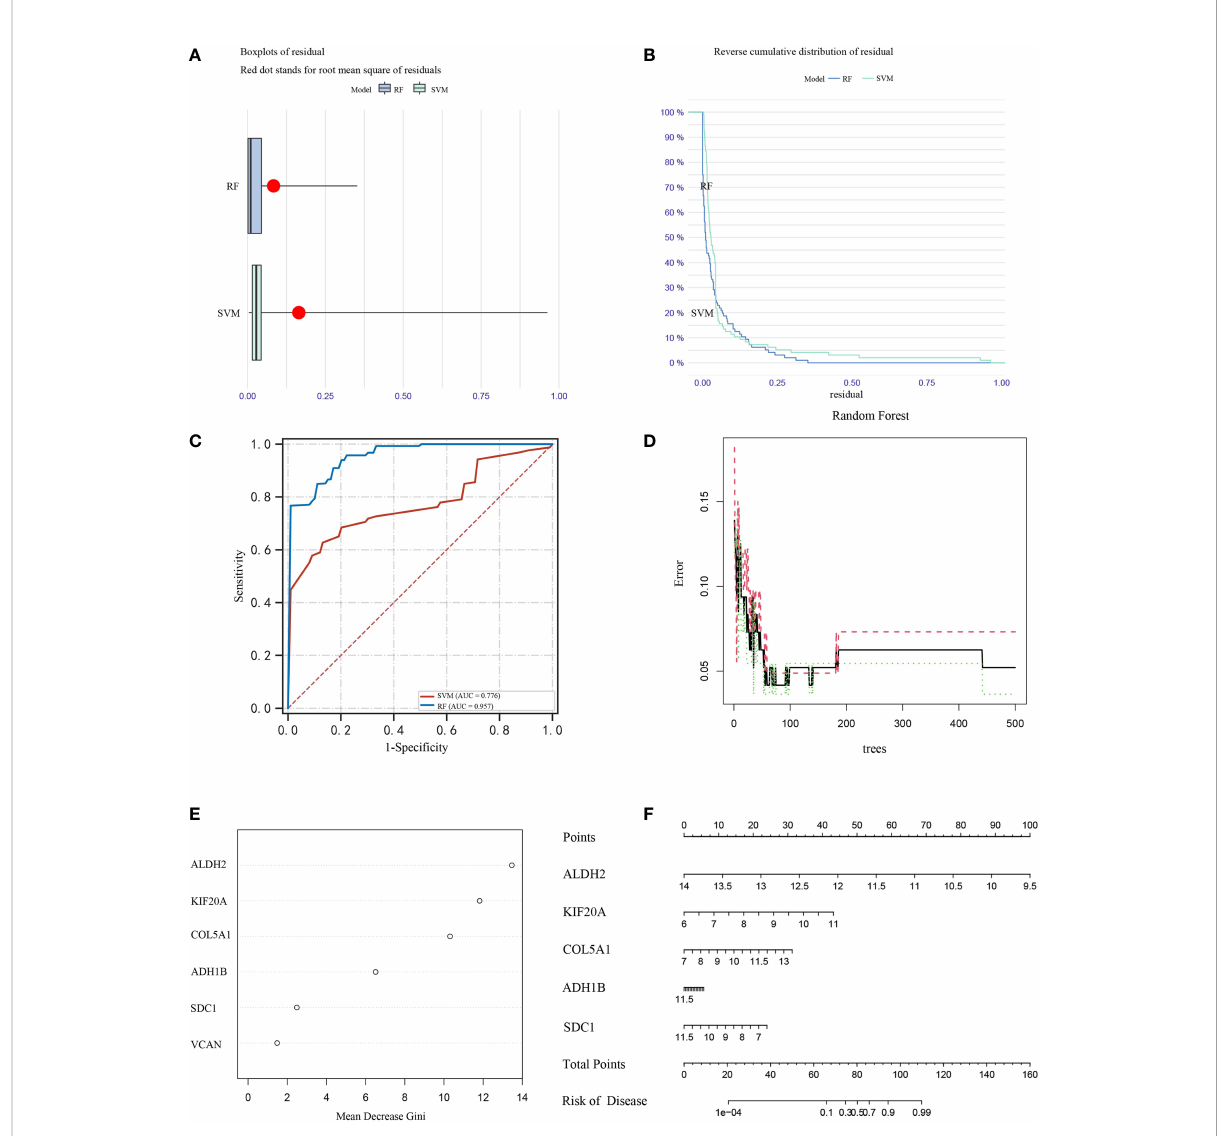
FIGURE 7 Box plots (A) and error analysis (B) of two unsupervised clustering methods for MPM-based differential expression of prognostic genes, and comparison of the accuracy (C) of the two classi fi cation modes, with the RF classi fi cation mode (D) classi fi er iteration process. (E) Ranking of the importance of prognostic genes in correlation with the risk of MPM prevalence, (F) disease models were constructed for the fi ve prognostic genes with the highest correlation with the risk of MPM